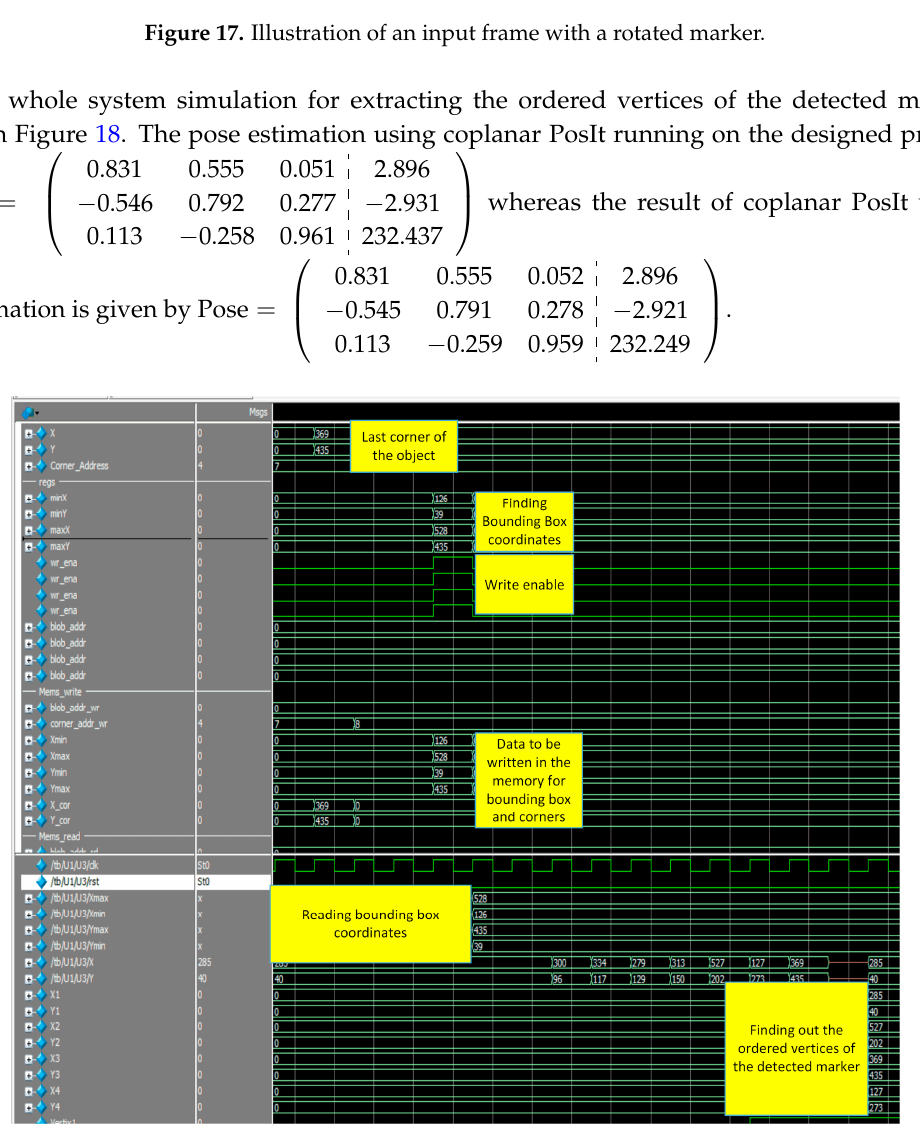
Figure 18. Whole system simulation results.